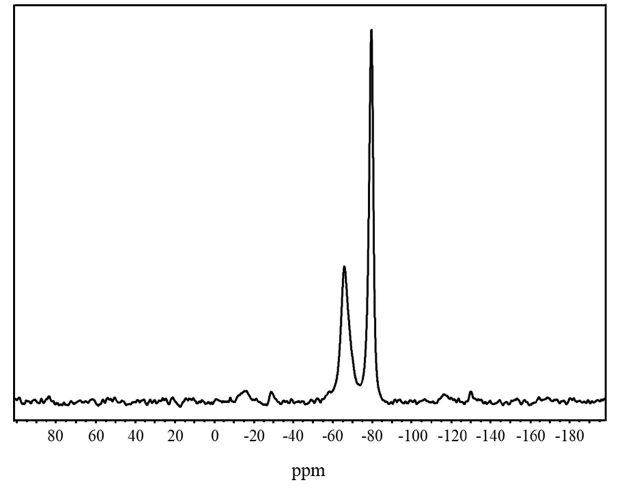
Polymers 2023 , 15 , x FOR PEER REVIEW Figure A3. Solid-state 29 Si MAS NMR spectrum of HPCP. Figure A3. Solid-state 29 Si MAS NMR spectrum of HPCP.